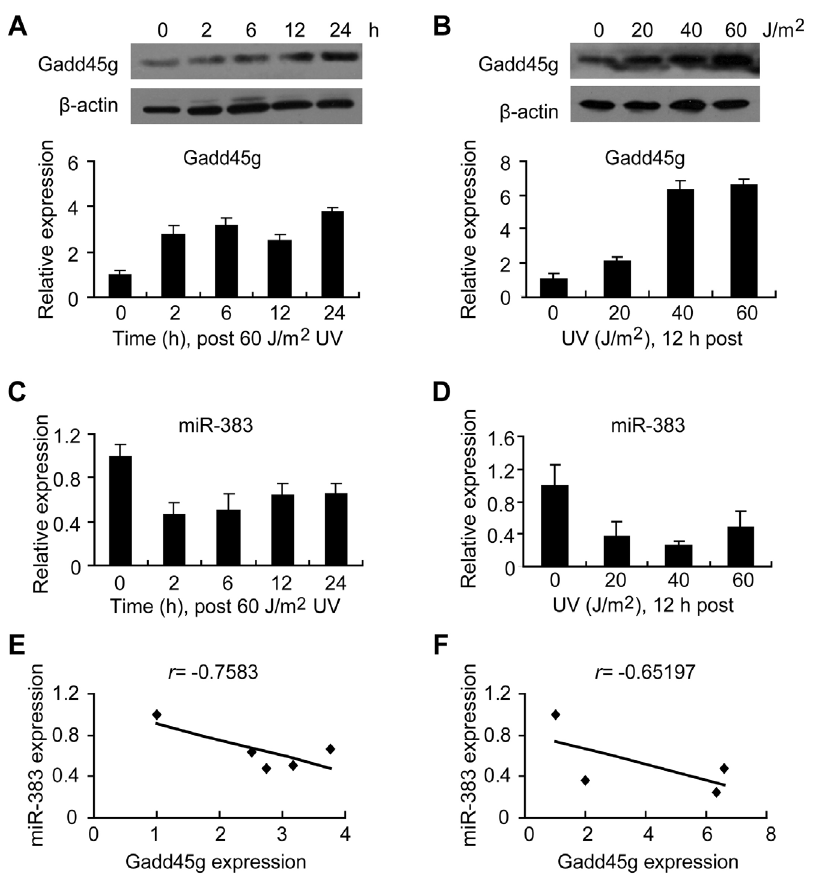
Figure 2. The expression of miR-383 and Gadd45g is negatively correlated post UV irradiation. (A) The mRNA level of Gadd45g was measured by qRT-PCR post UV irradiation (60 J/m 2 ) at indicated time in MCF-7 cells, and normalized to those of GAPDH (top). The mRNA level at 0 h was set as 1.0. The protein level of Gadd45g was measured by western blotting, and b -actin was used as a loading control (bottom). (B) Relative Gadd45g mRNA expression was measured by qRT-PCR 12 h post UV irradiation at different doses (top). The data at 0 J/m 2 was set as 1.0. Western blotting was used to analyze Gadd45g protein levels. b -actin was used as a loading control (bottom). (C and D) The expression of miR-383 was measured by qRT-PCR post UV irradiation (60 J/m 2 ) at indicated time (C) or different doses (D) in MCF-7 cells, and normalized to the level of U6. The data at 0 h or 0 J/m 2 was set as 1.0. Values are means ¡ SD. (E and F) A significant negative correlation was found between miR-383 and Gadd45g expression under UV irradiation post different time or at different